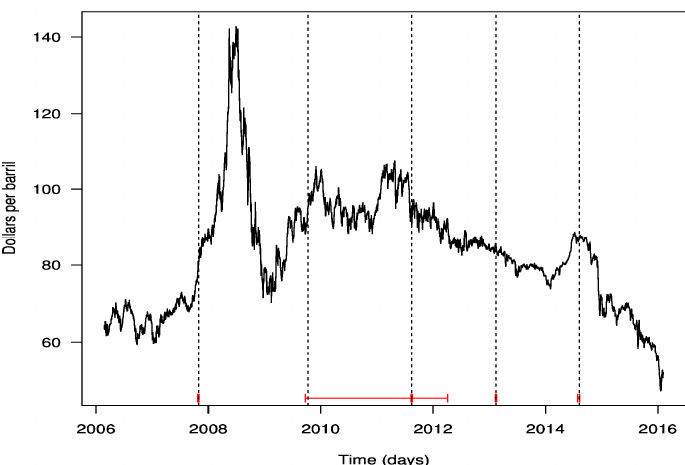
Figure D1. Significant structural breaks for the spot ( top ), futures estimated by a stochastic model ( middle ), futures obtained as the longest maturity ( bottom ), which were estimated by the change point method (Zeileis et al. 2003; 2015 [55,56]). Red bars indicate the confidence interval (95%) for each change point (dashed lines).